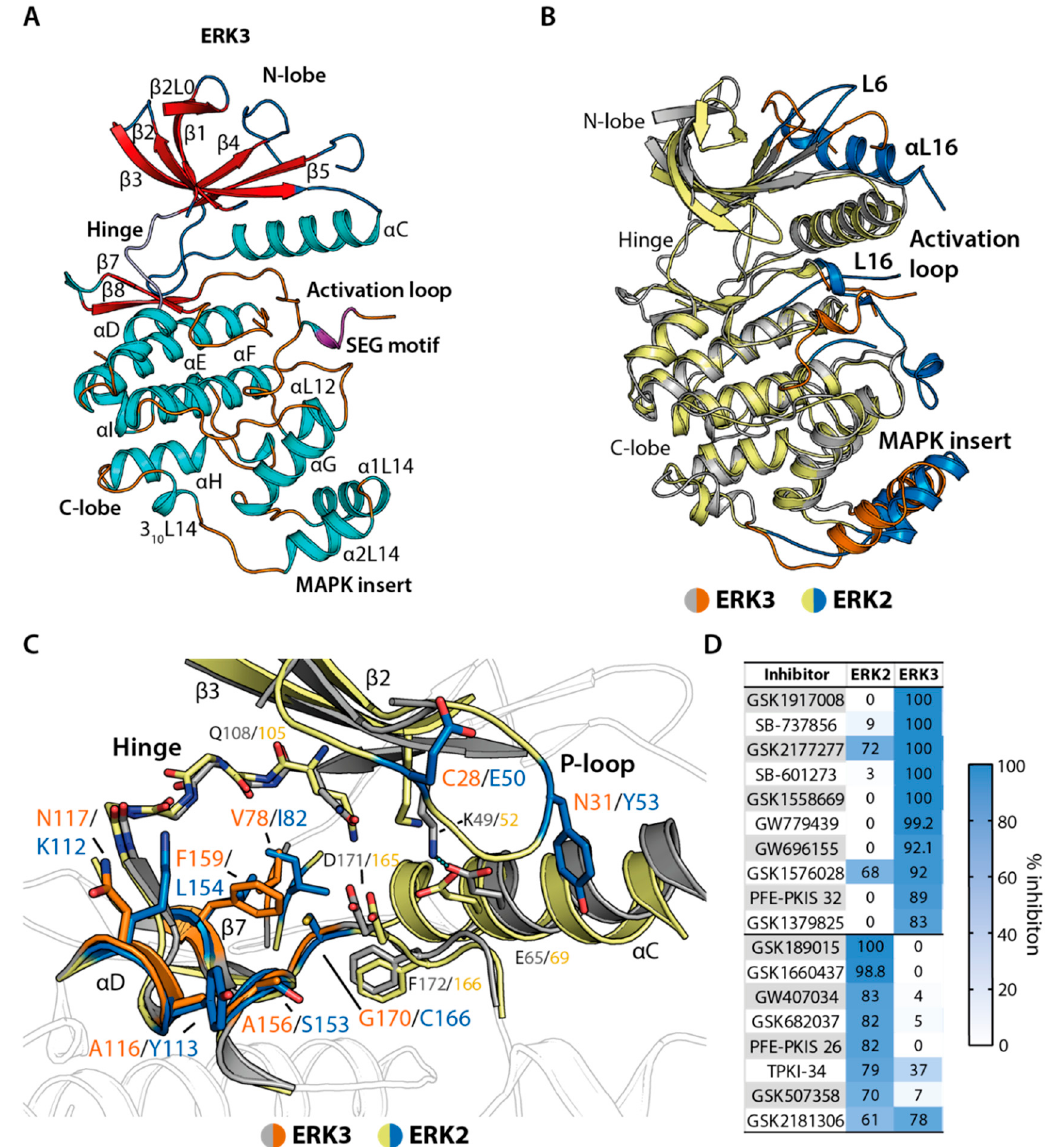
Figure 1. Crystal structure of extracellular signal-regulated kinase (ERK) 3 kinase domain and structural comparison with ERK2. ( A ) Crystal structure of the kinase domain of human ERK3 (PDB ID: 7aqb). Secondary structure elements are colour-coded, with α -helices shown in cyan and β -strands in red. ( B ) Superimposition of the kinase domains of ERK3 (grey) and ERK2 (yellow) (PDB ID: 5ngu [35]). Highlighted in orange (ERK3) and blue (ERK2) are the main differences between both structures. ( C ) Comparison of the ATP binding pockets of ERK3 (grey) and ERK2 (yellow). Amino acid differences between ERK3 (orange) and ERK2 (blue) are highlighted. ( D ) Examples of identified inhibitors for ERK2 and ERK3 from the published kinase inhibitor (PKIS) studies [6,7] reveal different inhibitor preferences between these two kinases.